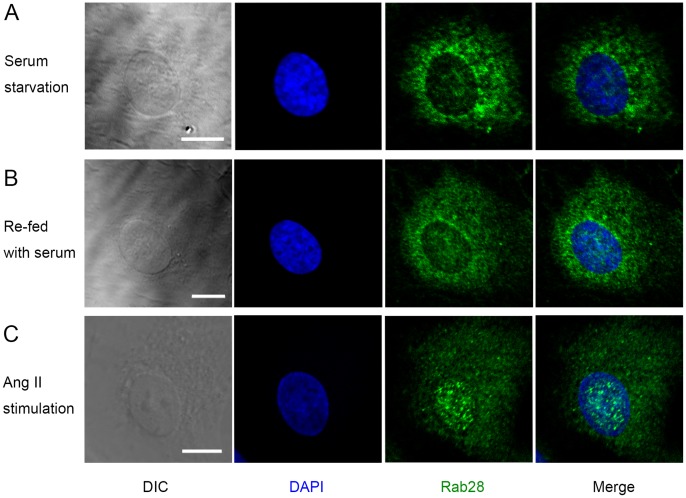
Intracellular distribution of Rab28 in ECs under different culture conditions.(A) ECs were starved in serum-free medium for 24 hours to growth arrest. Rab28 existed mainly in the cytoplasm. (B) ECs were re-fed with serum for 12 hours. Rab28 appeared in both the cytoplasm and the nucleus. (C) ECs were re-fed with serum and treated with 1×10−6 mol/L Ang II. Rab28 was distributed mainly in the nucleus. Scale bars: 10 µm.